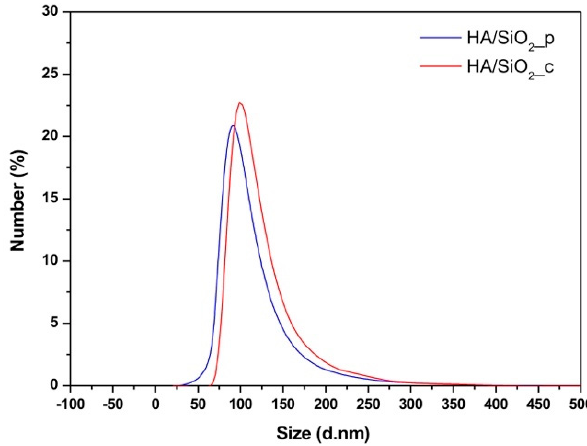
Figure 3. DLS analysis reported as the number distribution of SiO 2 /HA_p and SiO 2 /HA_c NPs.